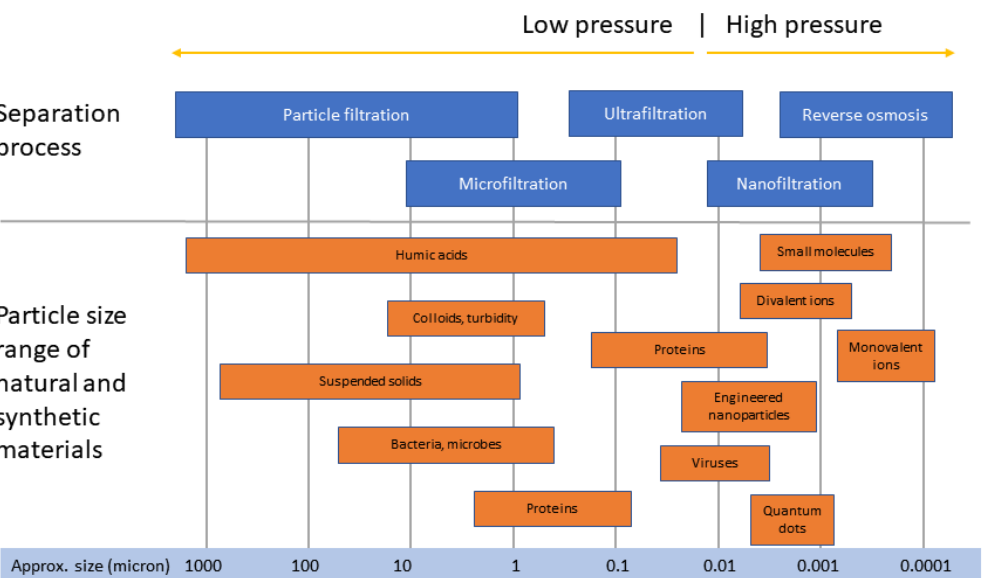
Figure 1. Schematic representation of membrane barrier performance.